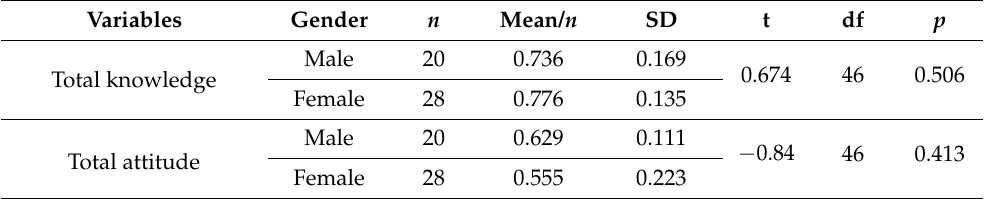
Table 5. Comparison of knowledge and attitudes among practitioners’ genders ( n = 48).